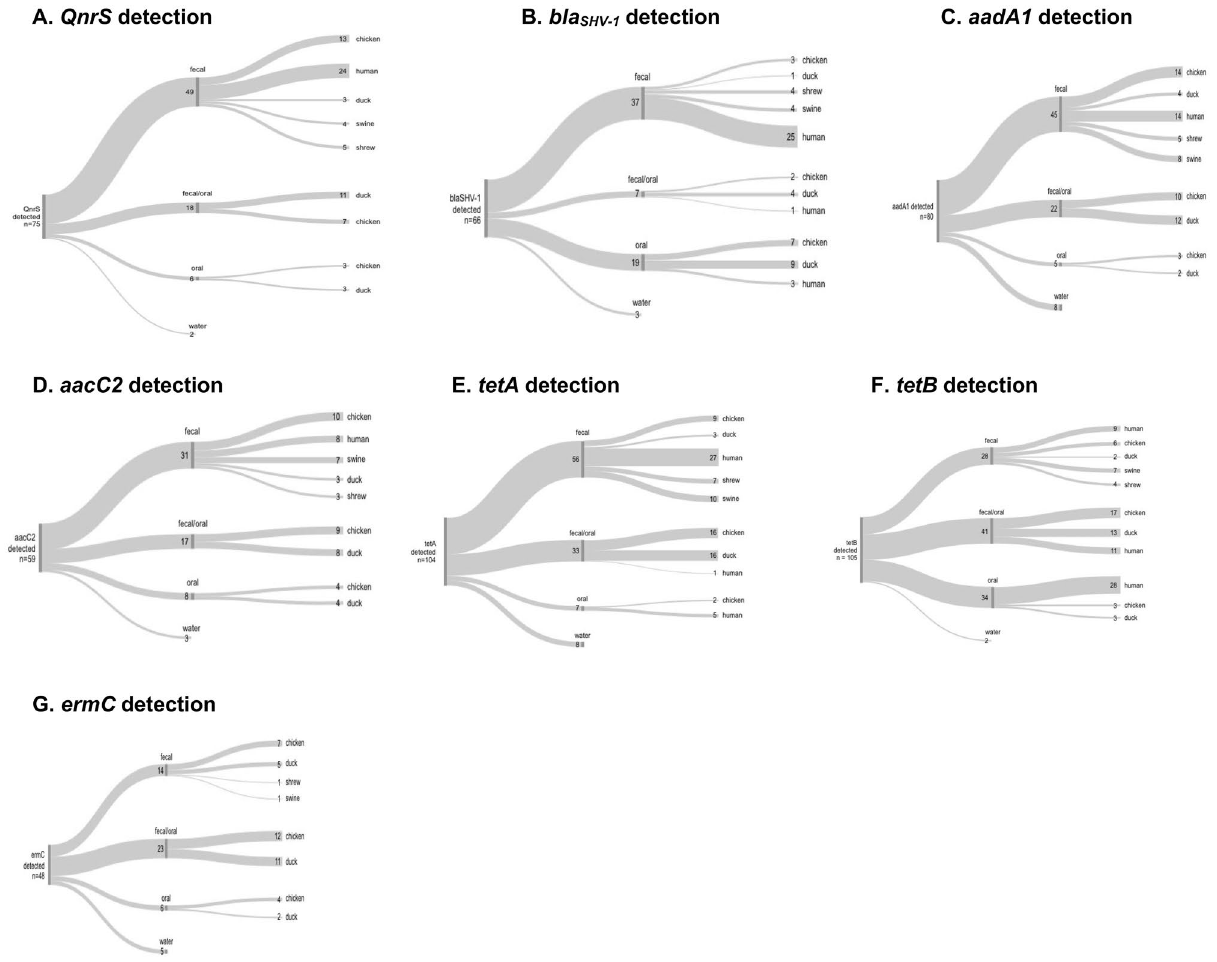
Figure 2. ( A–G ) Flowcharts of positive specimens from an urban, informal settlement in Kathmandu, Nepal separated by sample type and source sampled across seven antibiotic resistance genes of public health importance. Alluvial diagrams of positive specimens across seven antibiotic resistance genes of public health importance. Flow diagram should be read from left to right, with total numbers of samples positive on the left, sample type (fecal only, fecal and oral, oral only, or water) in the middle, and source sampled (chicken, duck, human, shrew, swine, water, or rodent) on the right. Numbers indicate number of samples positive for the AMR gene